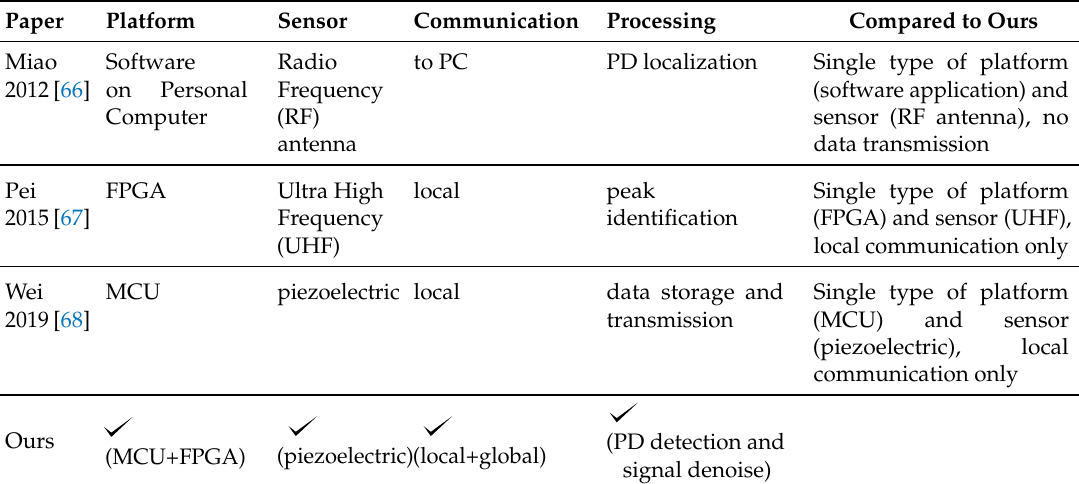
Table 4. Comparison with previous systems for PD